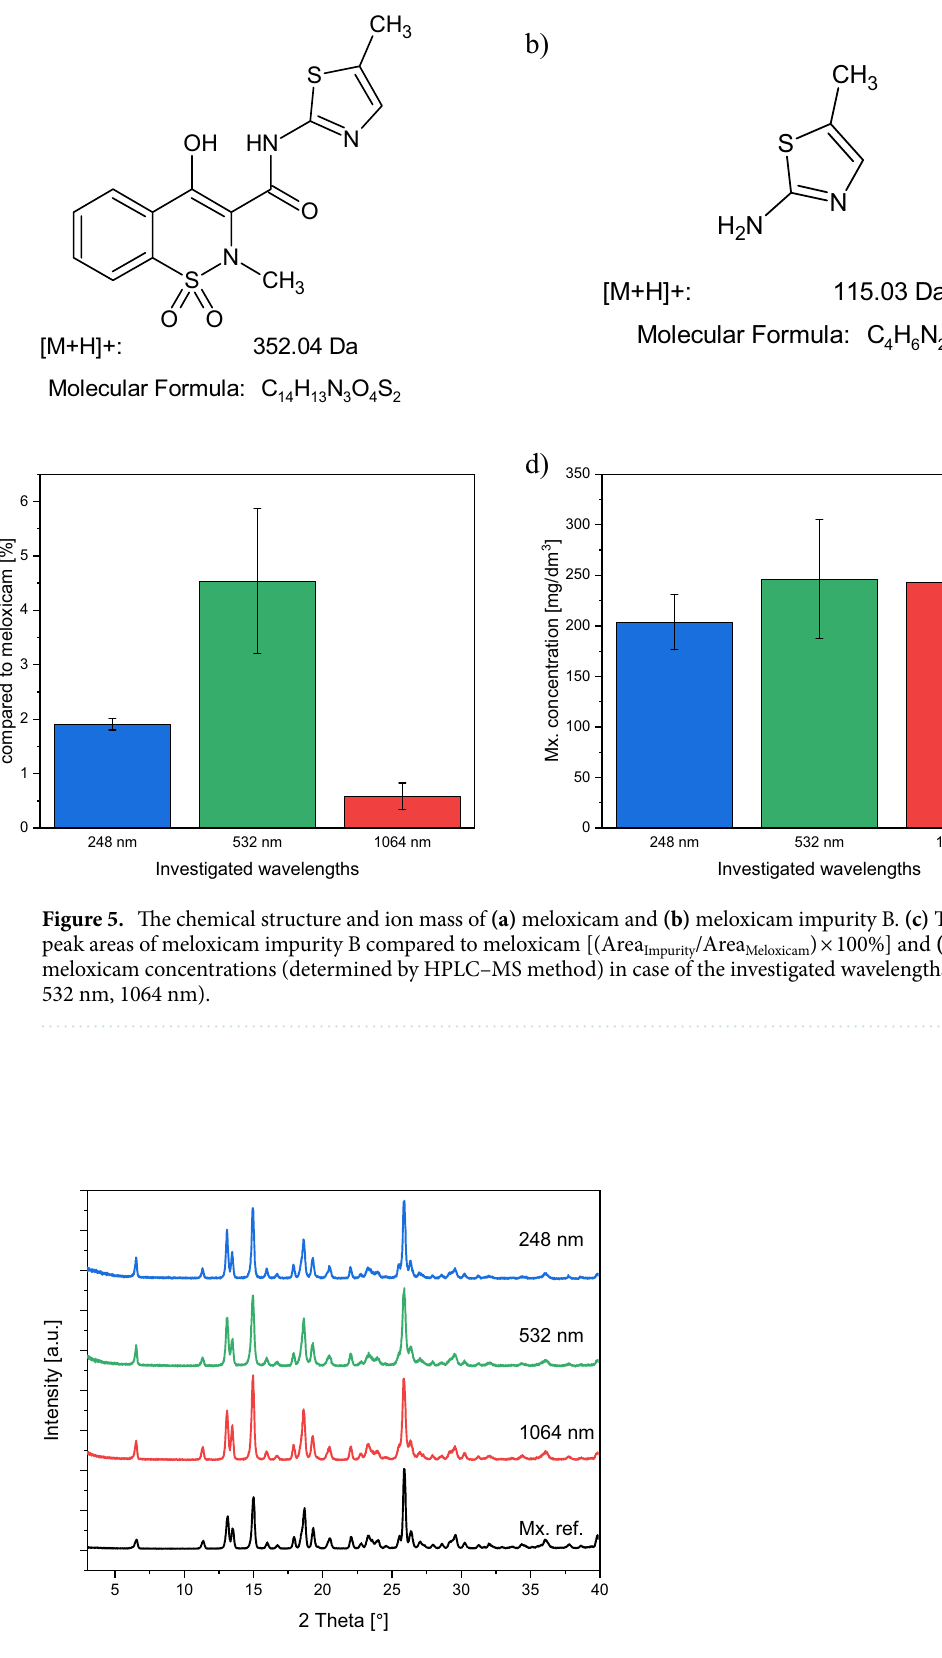
Figure 6. XRPD spectra of the particles prepared by PLAL at different wavelengths (248 nm, 532 nm, 1064 nm) and the meloxicam (Mx. ref.). Spectra were normalized to the peak at